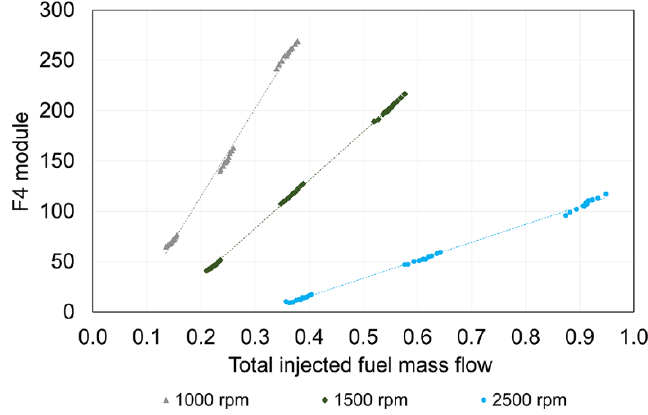
Figure 10. Correlation between the F4 module and the total injected fuel mass flow at different engine speeds and loads, in the case of homogeneous and nonhomogeneous injection. Data is normalized with respect to the maximum injected fuel quantity.